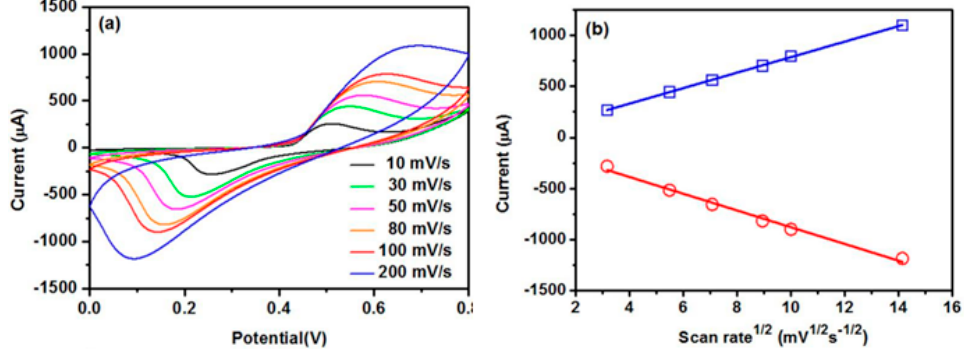
Figure 7. ( a ) CVs of CeO 2 /Ni(OH) 2 /CPE in 0.1 M NaOH solution containing 1 mM glucose at different scan rate; ( b ) Plot of the peak current with square root of scan rate.